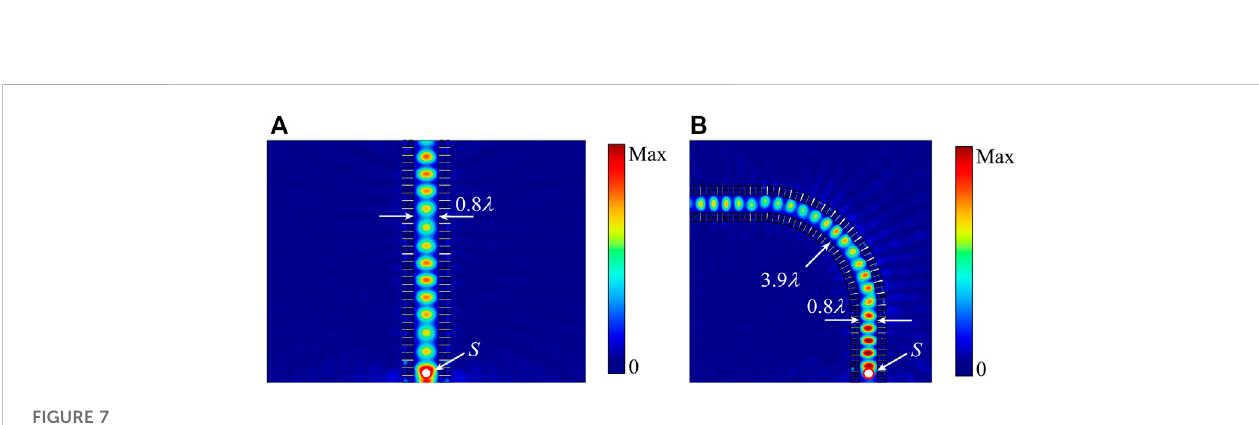
property, a channel is constructed by two metasurfaces as the route for wave propagation. When the wave propagates in the channel, it will be re fl ected by the metasurface boundary regardless of the incident angle. The channel can provide only one way for the wave to travel, despite its shape, that is, straight or curved. Figure 7 shows two examples of channelized waveguides for the A 0 -mode Lamb wave at frequency 14 kHz: one is a straight line and the other is in “ L ” shape. Figure 7A shows the energy fi eld of out-of-plane displacement (| w | 2 ) in a straight channel formed